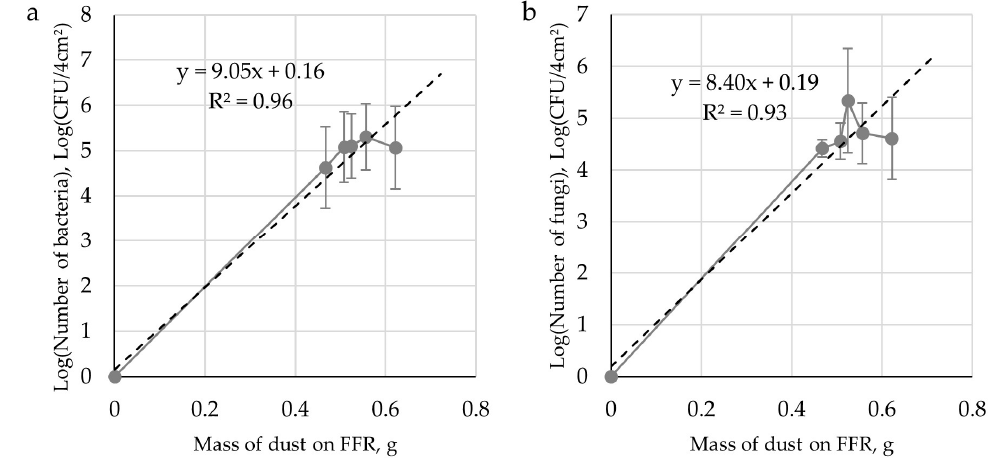
Figure 4. Logarithm dependence of the number of microorganisms and the mass of dust accumulated on FFRs ( a ) bacteria and ( b ) fungi.